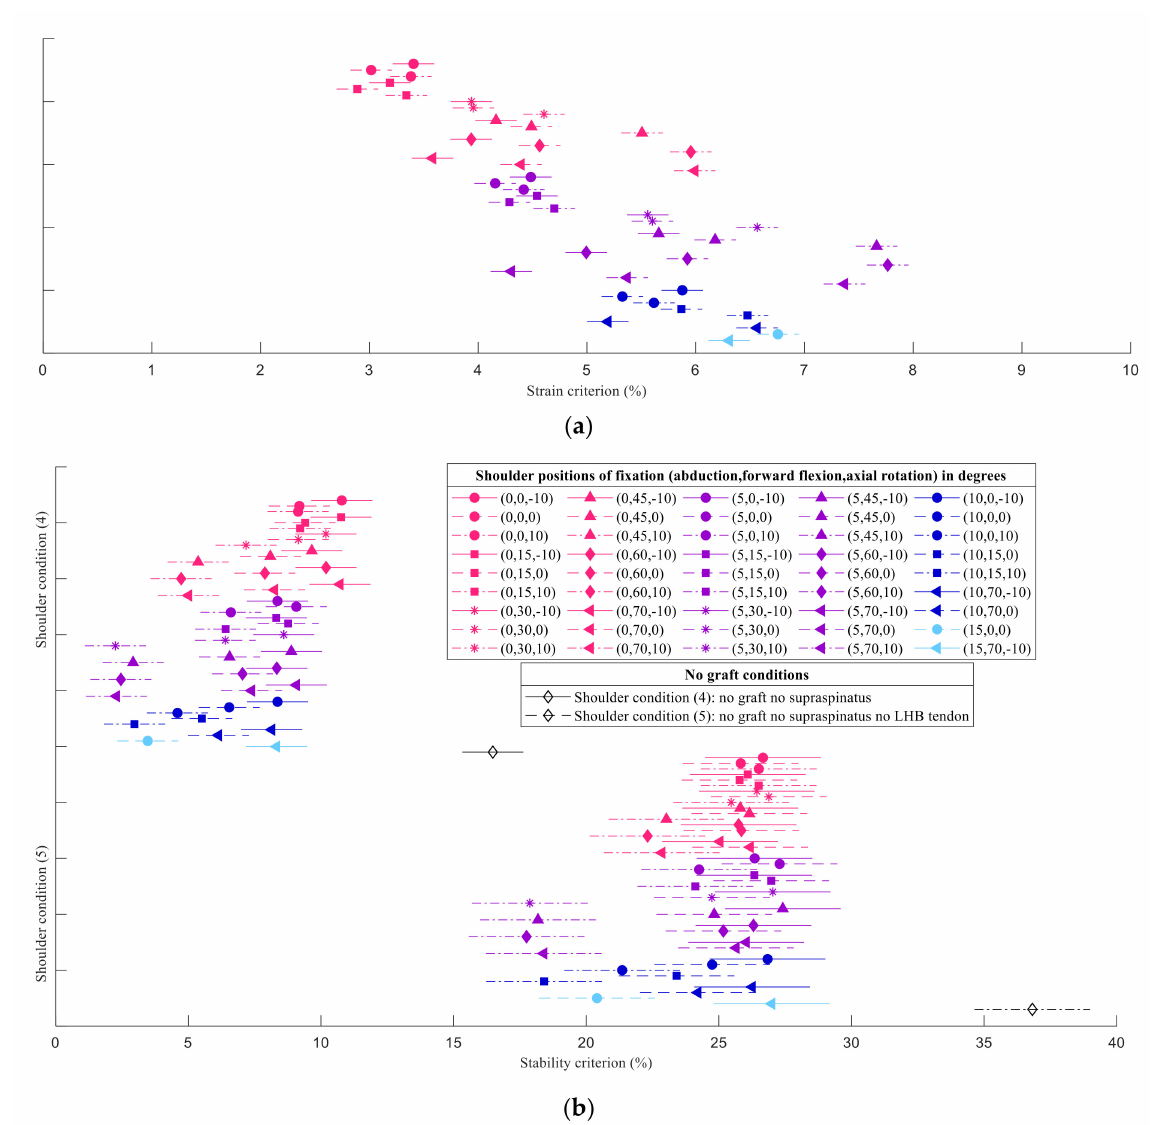
Figure 5. Multiple comparison test for the ( a ) strain criterion, equal for both shoulder conditions, and ( b ) stability criterion for the postoperative conditions, with a full-thickness tear of the supraspinatus tendon, condition (4), and with a full- thickness tear of the supraspinatus tendon and an LHB tendon that no longer transmitted force, condition (5). The markers represent the mean value of each group. The lines crossing the markers symbolize the respective comparison intervals. The difference between two means is statistically significant when the comparison intervals do not overlap. Shoulder positions of fixation are presented as “(abduction, forward flexion, axial rotation)”, in degrees, where positive axial rotations describe internal rotations. In ( b ), each shoulder condition is followed by the respective shoulder condition with no graft implanted. The healthy condition is represented by the stability criterion equal to